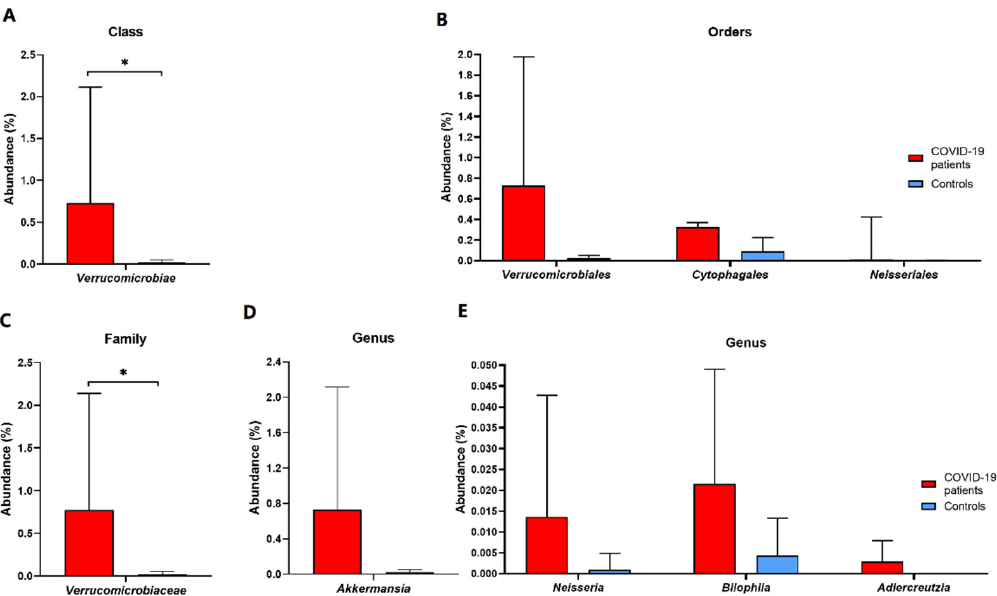
Figure 5. Differences in microbial composition between COVID-19 patients and healthy controls at class ( A ), order ( B ), family ( C ), and genus ( D , E ) level (mean values with SD). These data only concern initial statistically significant results calculated using the non-parametric Mann–Whitney test based on medians, and asterisks mark statistical significance obtained after multiple hypothesis testing corrections according to the Benjamini–Hochberg procedure * p < 0.05.